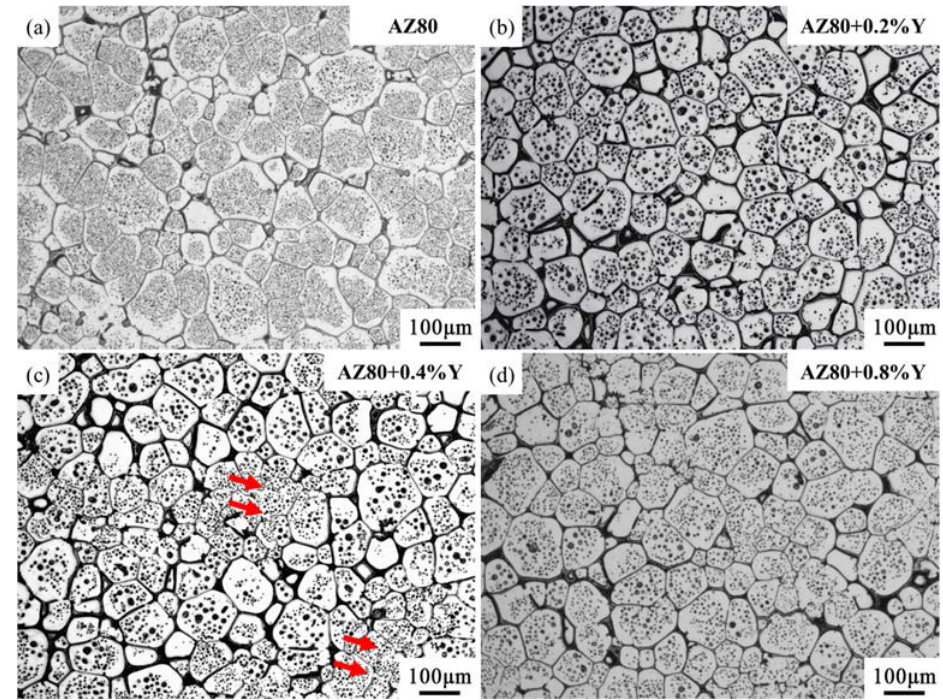
Figure 5. Microstructure evolution of alloys isothermally treated at 570 °C holding for 10 min: ( a ) AZ80; ( b ) AZ80M1; ( c ) AZ80M2; and ( d ) AZ80M3.